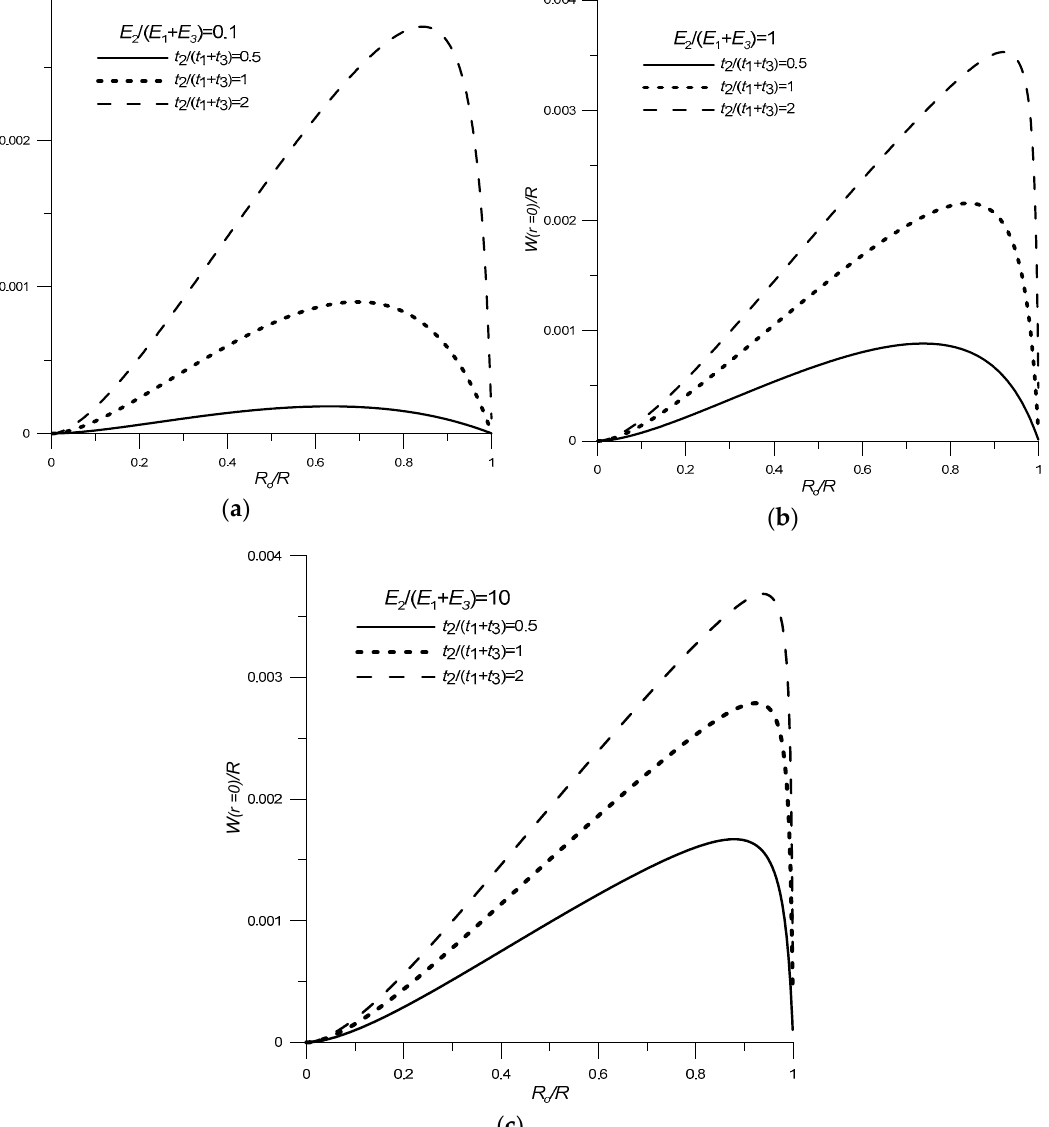
Figure 7. Influence of the ratio of elastic moduli, the relative thickness and the radius of piezo and non-piezoelectric materials on transducer deflection: ( a ) E g = 0.1, ( b ) E g = 1, ( c ) E g = 10; ν 1 = 0.34, ν 3 = 0.46, R = 0.06 m, t 3 = 0.0001 m, V = 100 V.